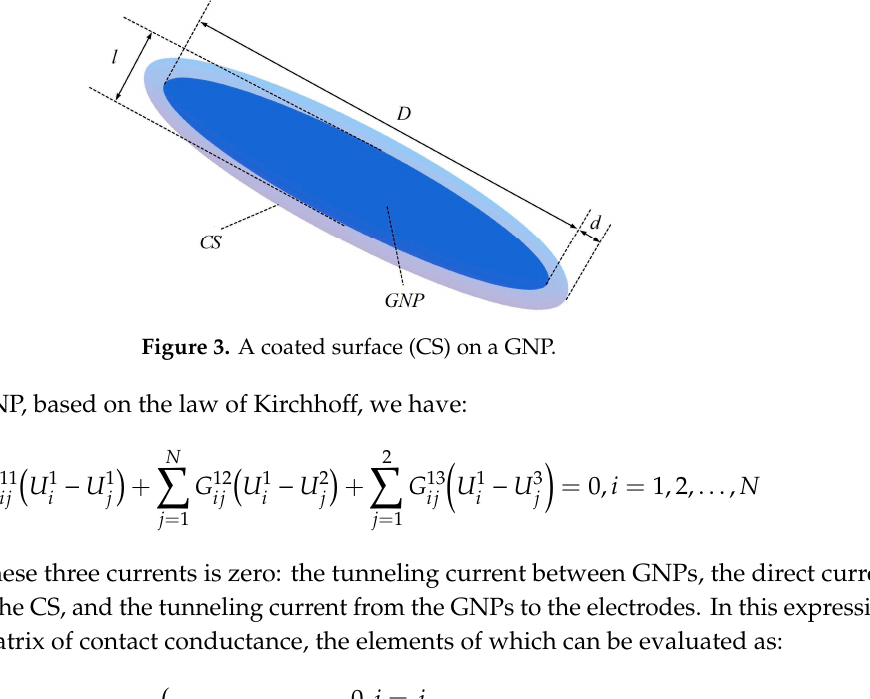
Figure 2. A diagram of G graphene (the conductance of graphene), G interlayer (the conductance between the top and bottom layer of a GNP), and G contact (the tunneling conductance between a pair of GNPs).